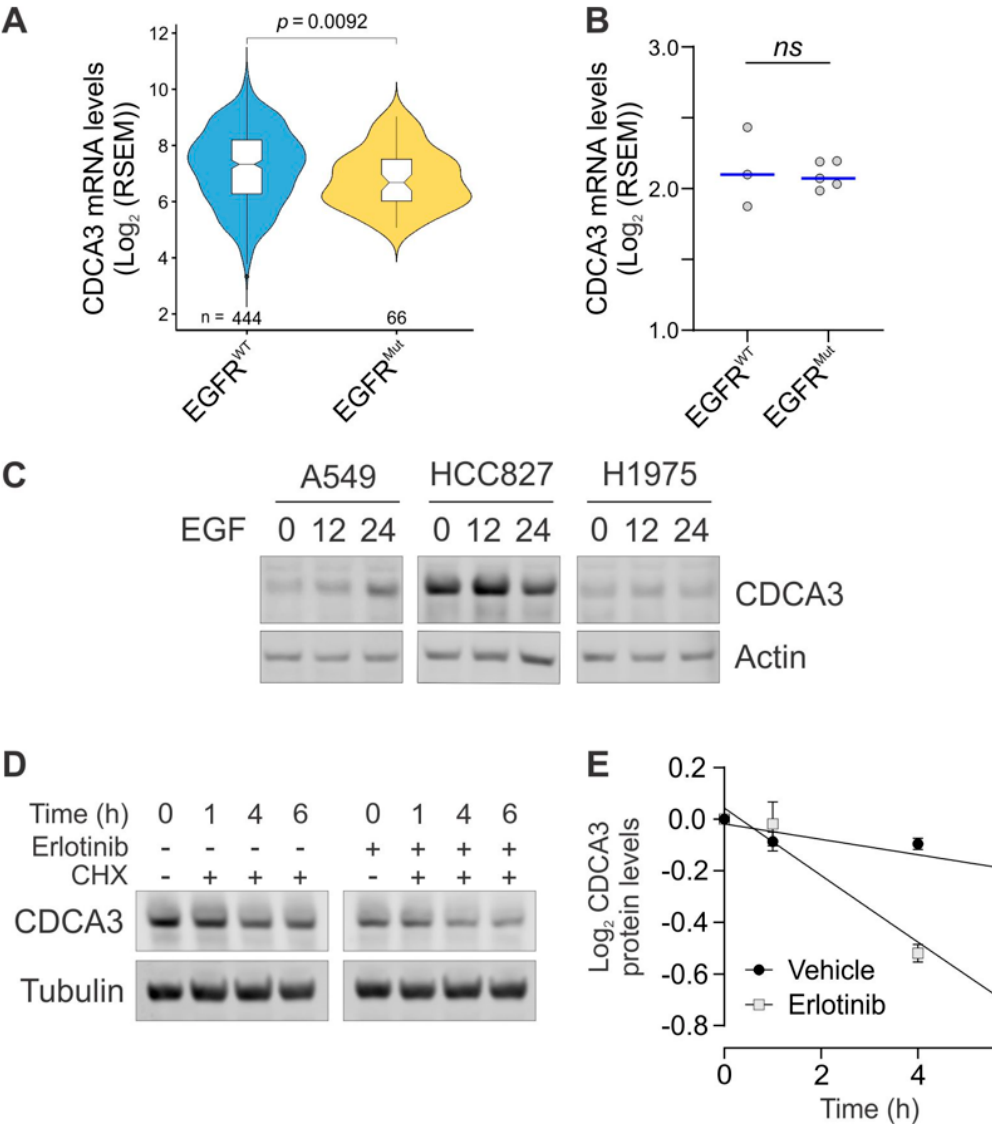
Figure 2. Upregulation of CDCA3 protein levels in EGFR mutant NSCLC is dependent on RTK signalling. ( A ) Violin plots showing relative CDCA3 mRNA levels in EGFR wild-type and EGFR mutant adenocarcinoma from The Cancer Genome Atlas (TCGA) RNAseq datasets. ( B ) RNAseq analysis of CDCA3 mRNA levels in cell lines examined in Figure 1C comparing EGFR wild-type and EGFR mutant adenocarcinoma. ns, not significant. ( C ) Endogenous CDCA3 Western blot analysis of A549 (EGFR WT), HCC827 (EGFR exon 19 deletion) and H1975 (EGFR T790M) cells treated in the absence or presence of EGF over 24 h. Phosphorylated (S473) and total Akt Western blot analysis to assess EGF-induced signal transduction. Actin used as a loading control. ( D ) Endogenous CDCA3 Western blot analysis of HCC827 lysates assessing protein turnover by treating with cycloheximide over 6 h in the presence or absence of erlotinib. Tubulin used as a loading control. ( E ) Densitometry quantification of ( D ), showing average log 2 of relative CDCA3 protein levels relative to 0 h from three independent